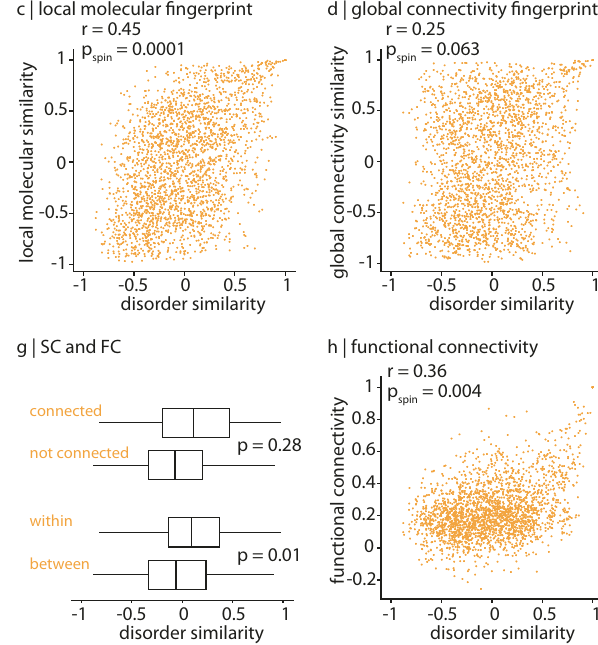
correlated to correlated gene expression (Pearson's r (559)=0.46, p spin =0.0001, CI=[0.40,0.53], two-tailed). g Disorder similarity is signi fi cantly greater within intrinsic functional networks than between networks, against the spin-test ( p =0.01; bottom). Disorder similarity is non-signi fi cantly greater between struc- turally connected regions than regions that are not connected, against a degree- and edge-length-preserving null model ( p =0.028 101 ). Bounds of the box represent the 1st (25%) and 3rd (75%) quartiles, the centre line represents the median, and whiskers represent the minima and maxima of the distribution. N connected =592 edges, N notconnected =1686. N within =388, N between =1890. h Disorder similarity is signi fi cantly correlated to functional connectivity (Pearson's r (2276)=0.36, p spin = 0.004, CI=[0.33,0.40],